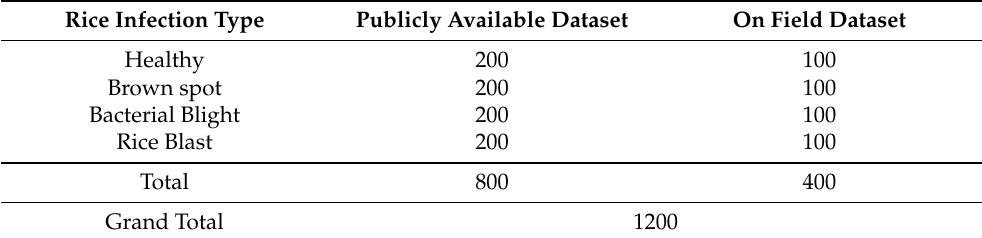
Figure 2. Rice grade architecture to quantify the rice disease severity level. Table 1. Total number of rice images used for the proposed